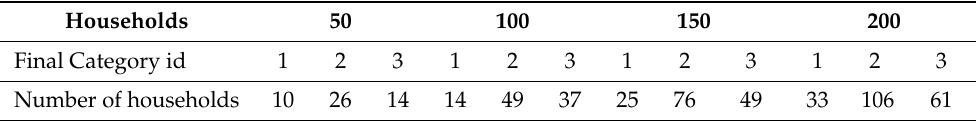
Table 5. Load aggregation results for the number of households of different sizes.